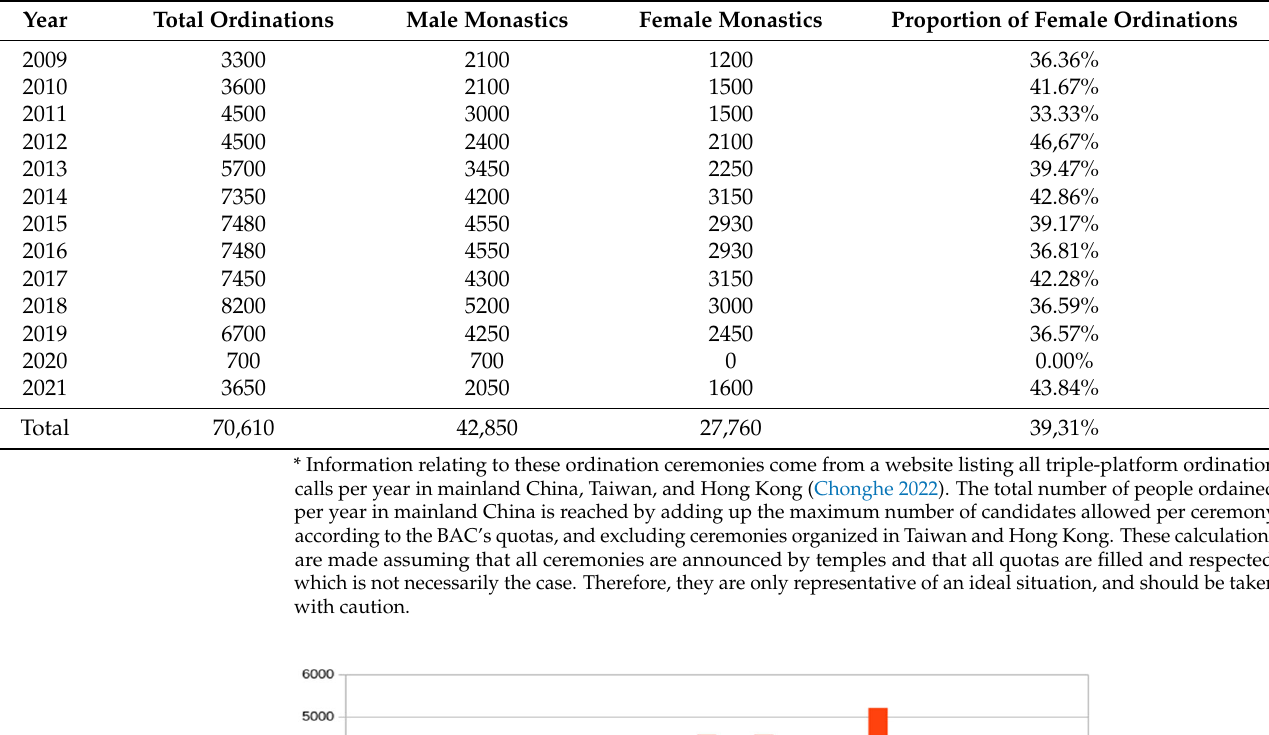
Table 1. Official ordination numbers per year since 2009 *.